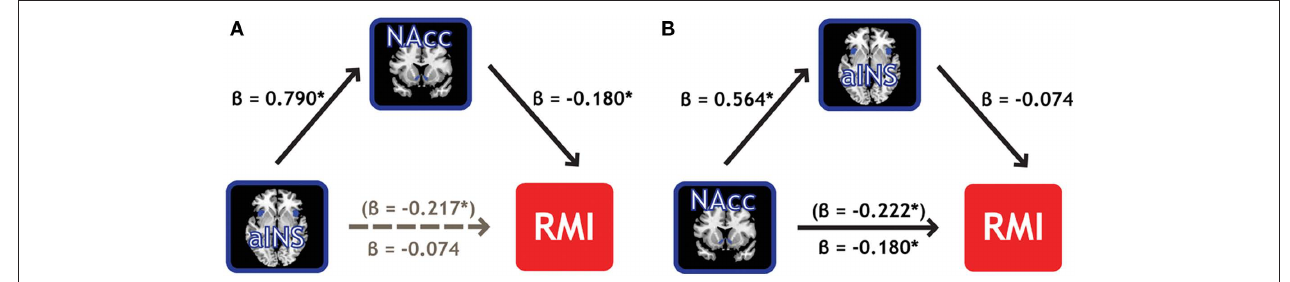
FIguRe 6 | NAcc activation mediates the effect of aINS on relative reward motivation index. (A) Individual variability in bilateral NAcc mediates the contribution (gray path) of bilateral aINS to the RMI. We found that NAcc mediated 66% of the effect of aINS. (B) Individual variability in bilateral aINS, however, did not mediate the effect of bilateral NAcc